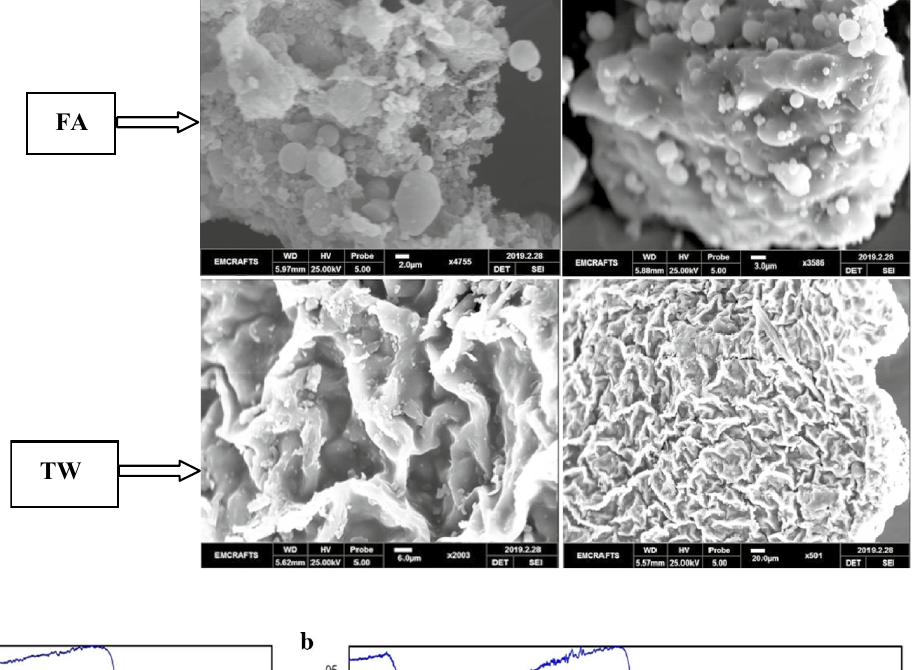
Fig. 8 SEM images of FA and